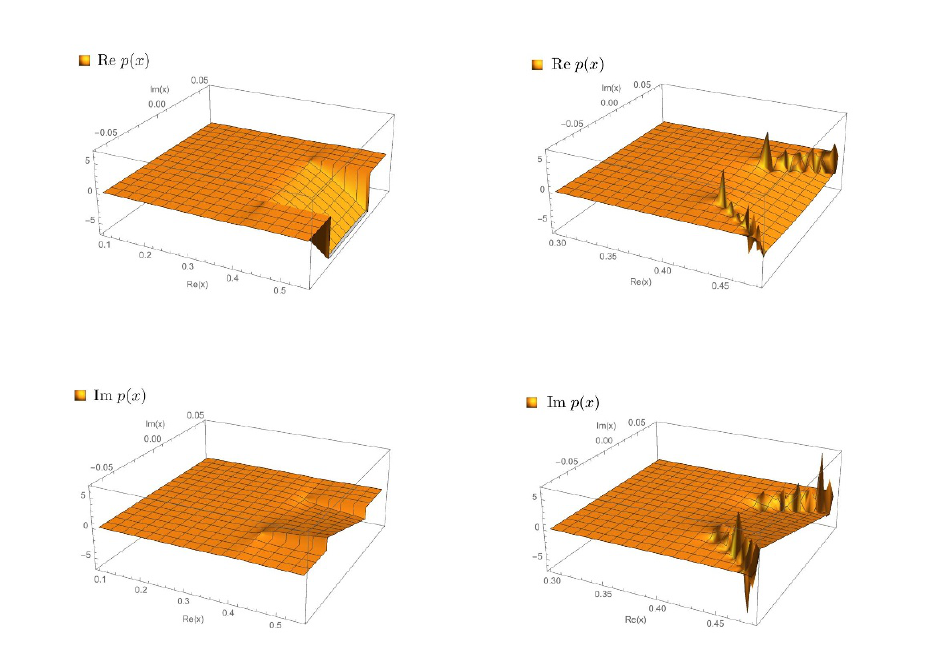
Figure 15 . Modulus of the (cid:12)nite c vacuum block that connects the zeros.